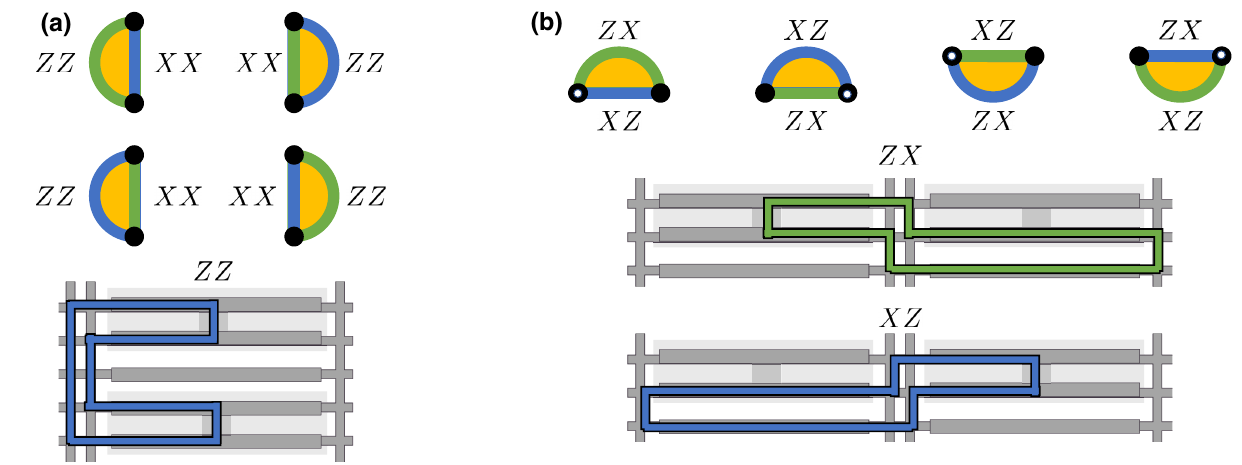
FIG. 5. The boundary measurements for the 4.8.8 Floquet code. (a) 2-gons along vertical boundaries require ZZ between vertically adjacent qubit islands, which can be implemented using both semiconducting columns to the left or right of the qubit. (b) 2-gons along horizontal boundaries require ZX and XZ between horizontally adjacent qubit islands, which can be implemented using the coherent links above or below the qubit islands. The white dot indicates that, for convenient physical implementation, the roles of the X and Z operators are swapped for that qubit as compared to the bulk. For example, a horizontal edge is assigned ZZ in the bulk but becomes either XZ or ZX when an end point is marked by the white